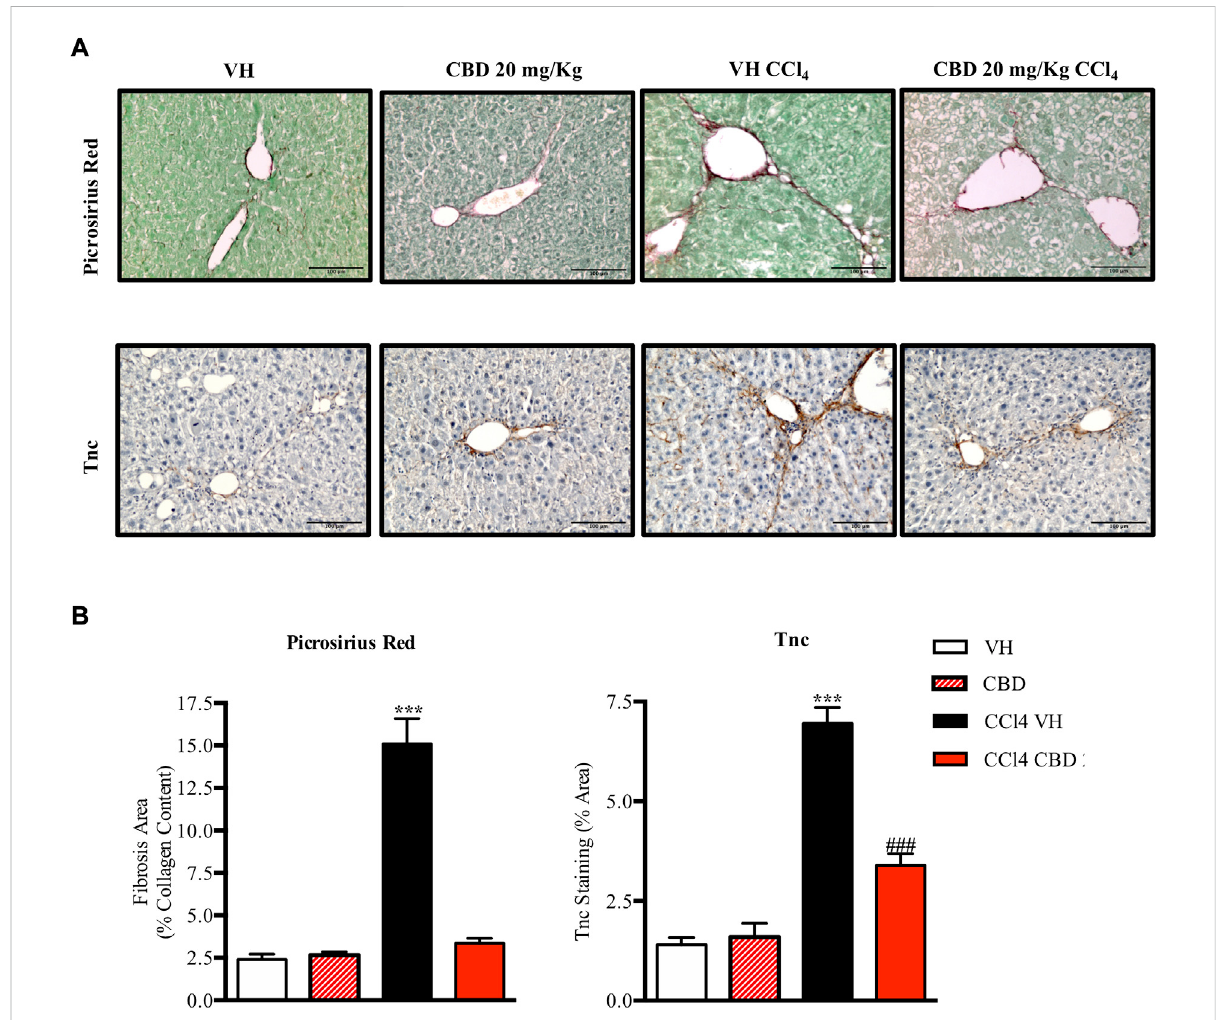
FIGURE 5 CBD reduces liver fi brosis induced by CCl4. (A) Representative images of collagen staining in the liver using picrosirius red dye (upper panel) or immunostainingwithTnc(bottompanel)fromcontrol,CBD,CCl4-vehicle,andCCl4+CBDmice.Scalebarsrepresent100and50 μ m,respectively. (B) Quanti fi cation of positive collagen content (left panel) and Tnc staining (right panel), expressed as a percentage of the total liver area. Values are expressed as mean ± SEM (n = 6 animals per group). *** p < 0.001 vs. control group; ### p < 0.001 vs. CCl4 group (ANOVA followed by Tukey ’ s